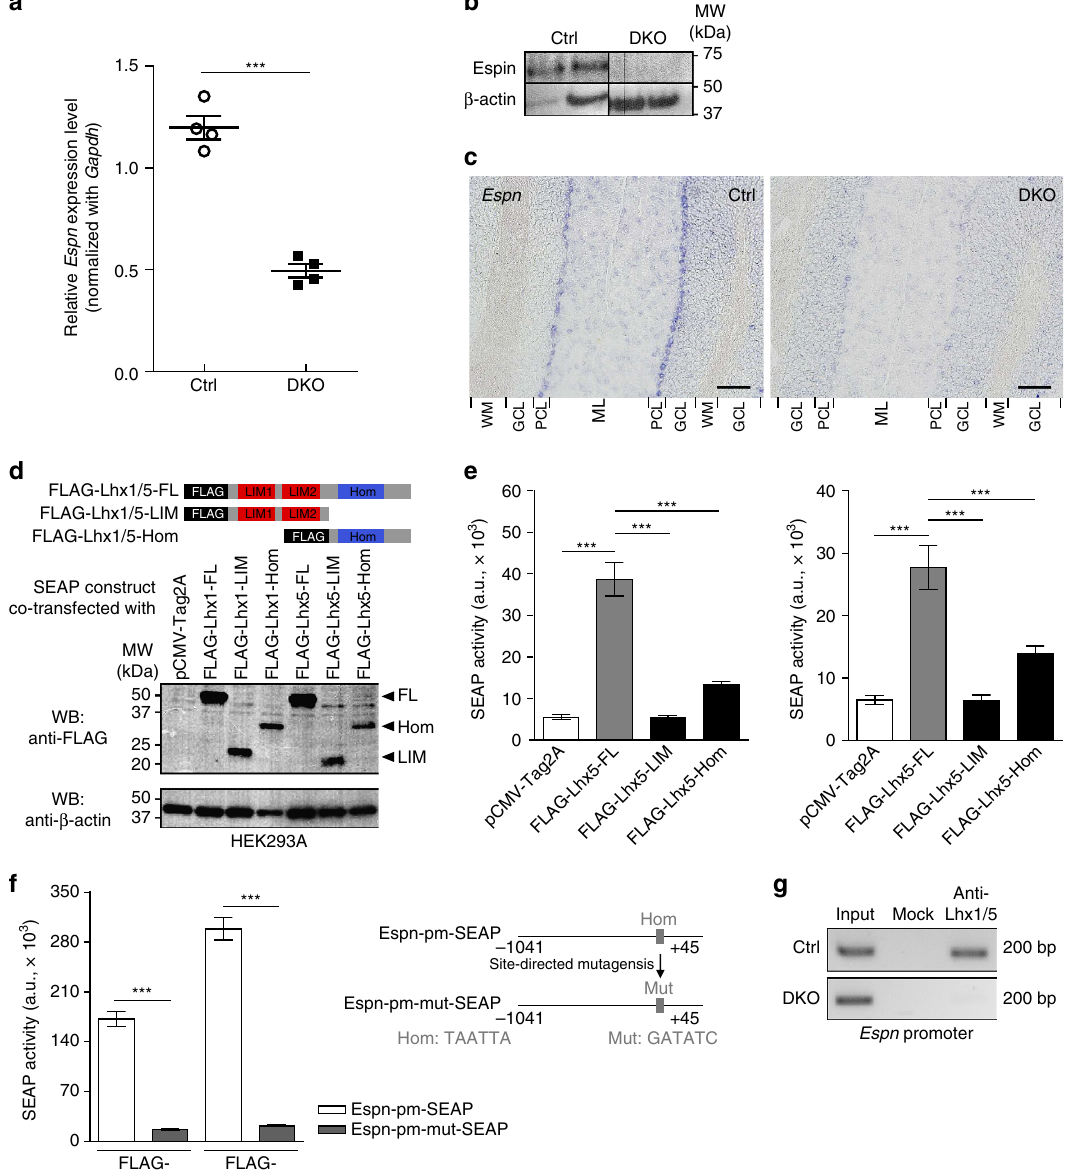
Figure 3 | Lhx1/5 transcriptionally regulate Espn . ( a ) Real-time quantitative PCR showing the relative Espn expression level in the adult DKO mutant cerebellum when compared with the control cerebellum; n ¼ 4 mice per group; t- test; *** P o 0.001. ( b ) Western blots showing the cerebella of the DKO mutants had lower Espin level than the controls. The experiment was repeated twice, seven mice for each genotype. ( c ) In situ hybridization for Espn transcripts showing the PCs of the DKO mutants (right) had a lower Espn expression than the controls (left). The experiment was repeated three times with three mice per genotype. ML, molecular layer; PCL, Purkinje cell layer; GCL, granule cell layer; WM, white matter. Scale bars, 100 m m. ( d ) Schematic illustrations showing different forms of FLAG-tagged Lhx1/5 proteins. Western blots showing the coexpression of Lhx1/5 proteins with SEAP. FL, full-length; LIM, LIM domains; Hom, homeodomain. ( e ) Bar graphs showing the differences in SEAP activity under the control of the Espn promoter (Espn-pm-SEAP) when different forms of Lhx1 (left) and Lhx5 (right) proteins were coexpressed. Analysis of variance (ANOVA); *** P o 0.001. ( f ) Schematic illustrations showing the SEAP plasmid containing an Espn promoter with mutation (Mut) in the binding site of Lhx1/5 homeodomain (Hom). Bar graphs reveal the differences in the SEAP activity with and without the mutation in the Espn promoter. For all SEAP assays, at least three independent replications were performed and n ¼ 9 for each group of experiments; t -test; *** P o 0.001. ( g ) Chromatin immunoprecipitation (ChIP)-PCR showing the in vivo binding of Lhx1/5 on Espn promoter in the controls (top) but not in the DKO mutants (bottom); n ¼ 2 mouse cerebella pooled for each group. The ChIP experiment was repeated three times, each with two different mouse cerebella per group. NATURE COMMUNICATIONS|8:15079|DOI: